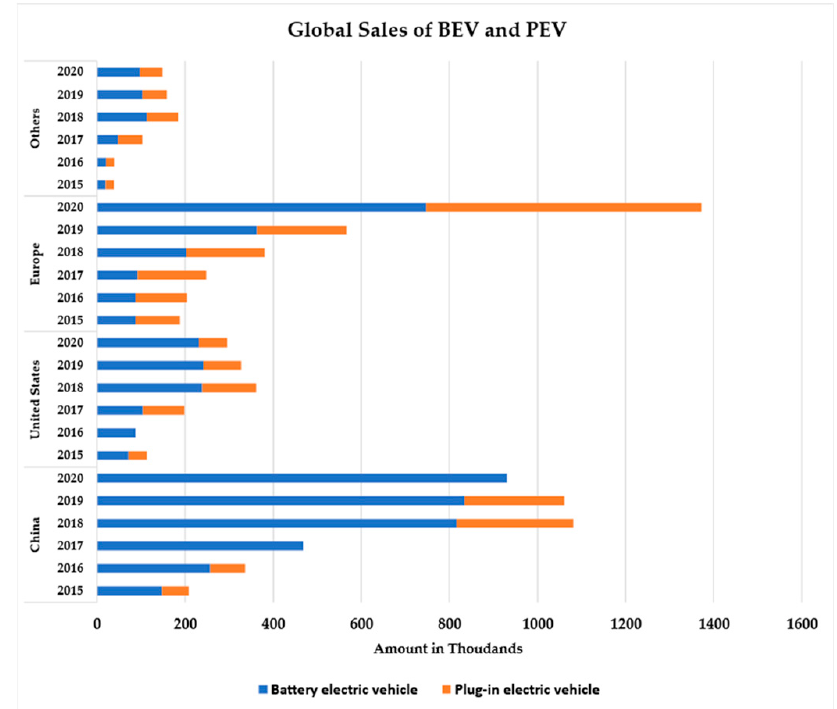
Figure 1. Electric vehicle sales (in thousands) in 2015–2020 (blue is used for BEV and orange for PEV) [4].